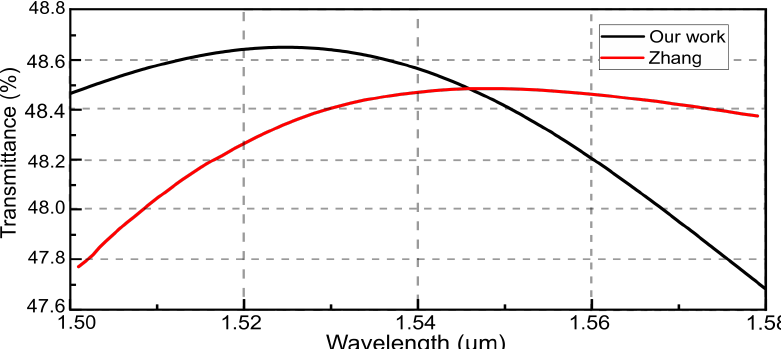
Figure 5. Waveband performance of our work compared with Zhang’s device [12]. Our work shows the best result using